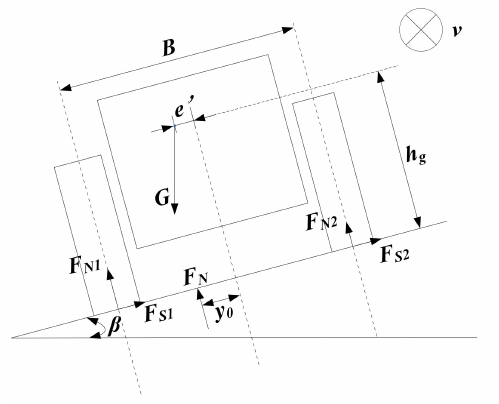
Figure 14. Force analysis of tracked vehicle on lateral